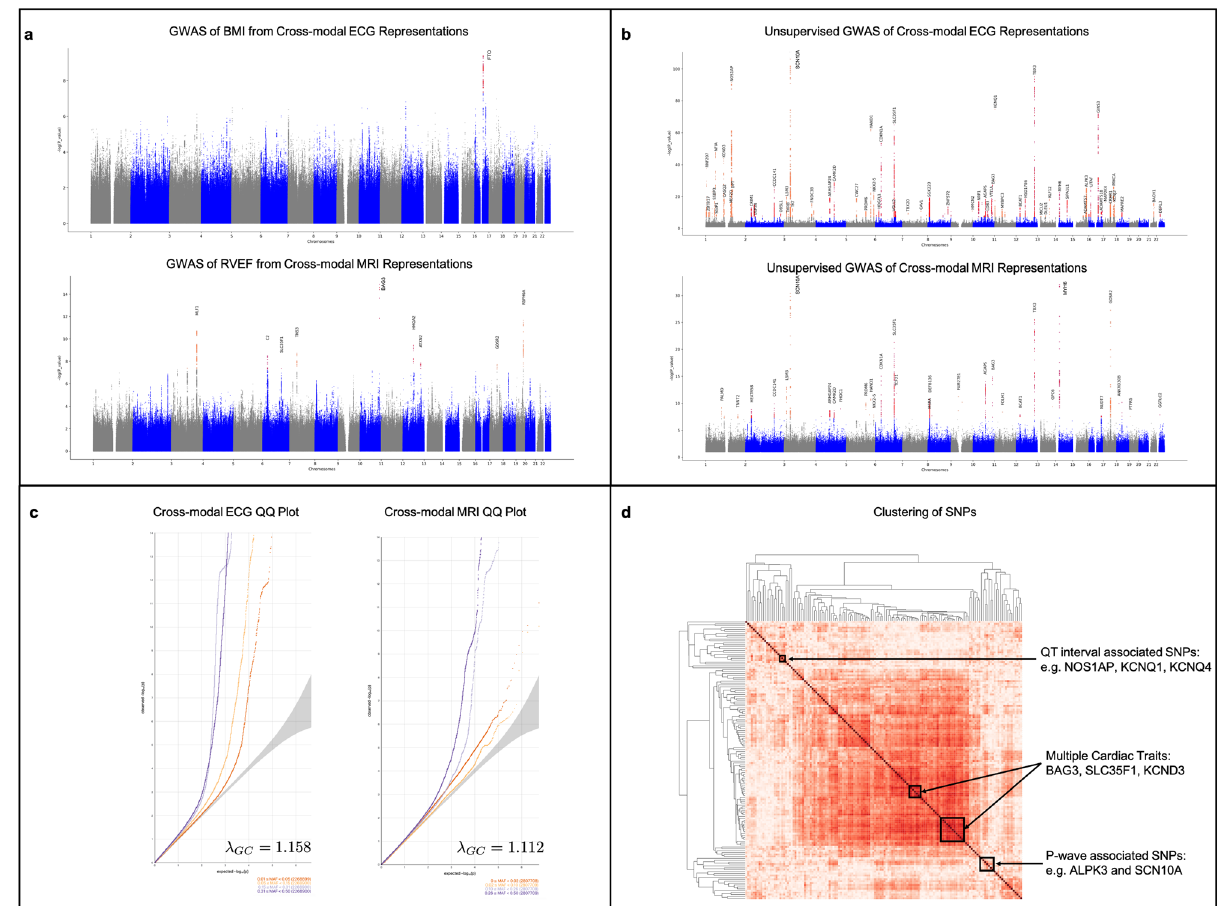
Fig. 4 | Cross-modal autoencoders capture genotype – phenotype associations for cardiovascular data. a Manhattan plots for GWAS of BMI and RVEF derived from cross-modal embeddings identify lead SNPs associated with these traits. For BMI, such GWAS identi fi es SNPs associated with FTO, which is known to have an effectonBMIandobesityrisk.ForRVEF,suchGWASidenti fi esSNPsassociatedwith BAG3, HMGA2, and MLF1, which have been previously associated with RVEF. b To more generally capture genetic associations with the heart, a GWAS can be per- formedinthecross-modalECGandMRIlatentspaceevenintheabsenceoflabelled data.TheManhattanplotsofsuchunsupervisedGWASidentifyleadSNPsincluding those associated with NOS1AP, TTN, SCN10A, SLC35F1, KCNQ1, which have been